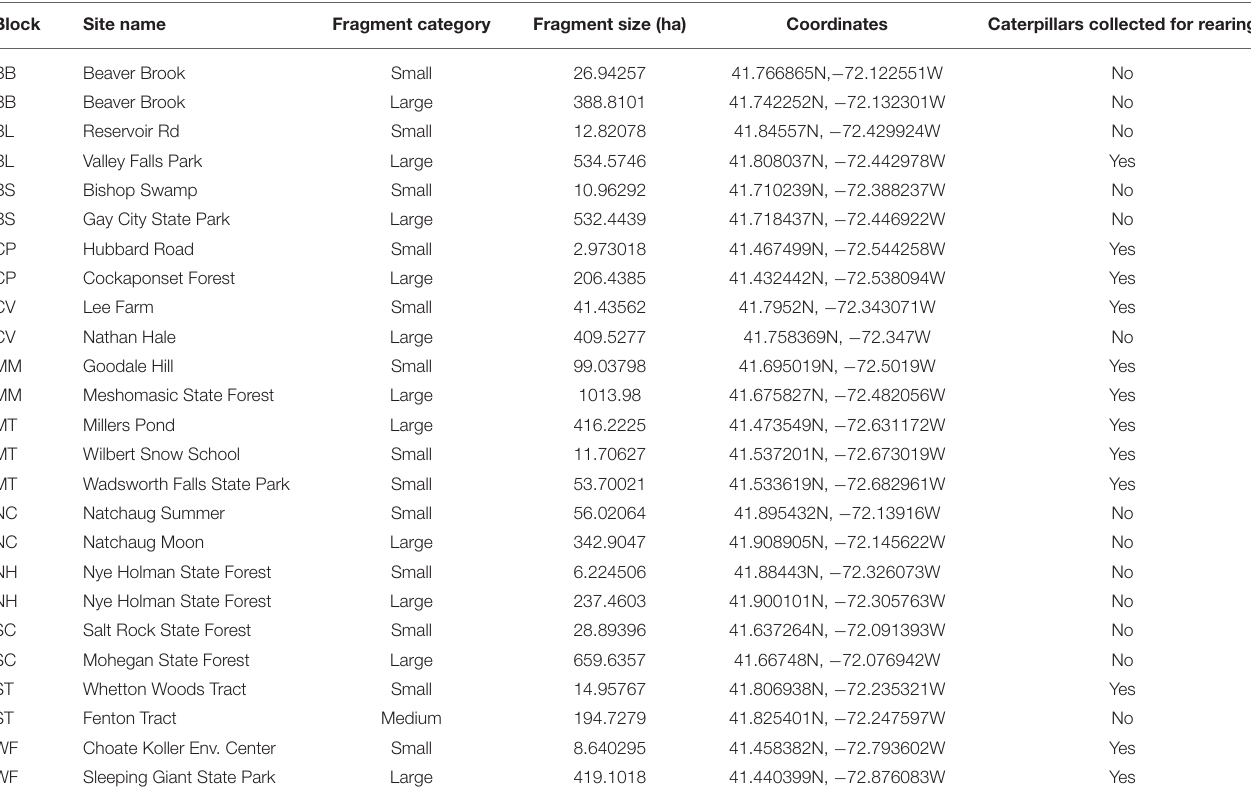
TABLE 1 | Forest sites used varied in size by two orders of magnitude.